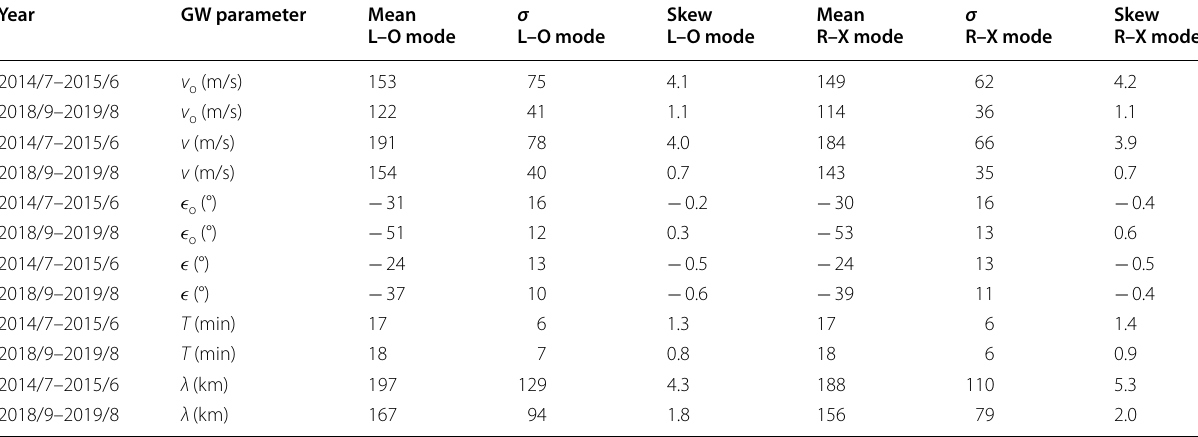
Table 1 Basic statistical values of selected GW parameters for periods 2014/7–2015/6 (solar maximum) and 2018/9– 2019/8 (solar